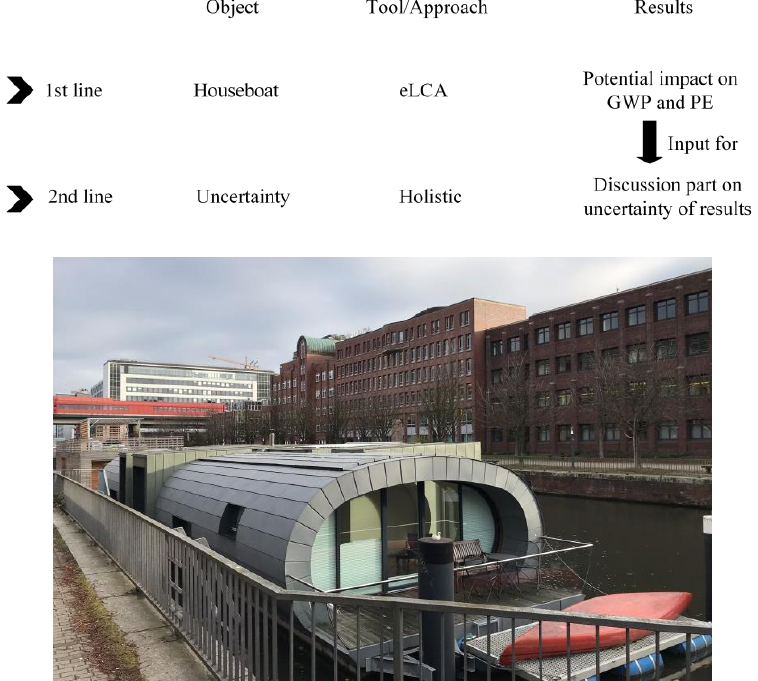
Fig. 1. Houseboat Swan. Author: Cesar